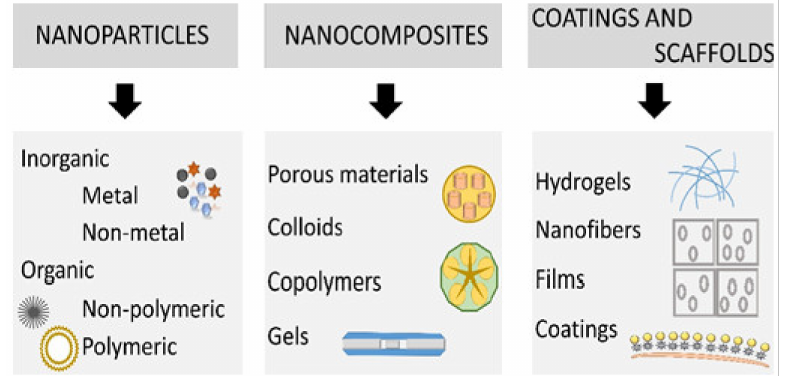
Figure 4. Main types of nanomaterials explored in wound treatment. Reprinted with permission from MDPI